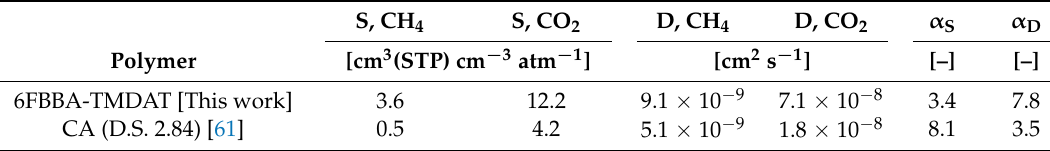
Table 3. CO 2 and CH 4 pure-gas solubility (S, measured gravimetrically) and diffusion coefficients (D), together with CO 2 /CH 4 solubility selectivity, and CO 2 /CH 4 diffusivity selectivity (2 atm and 35 ◦ C) for 6FBBA-TMDAT polyamide and CA [64]. Diffusion coefficients were calculated from D = P / S